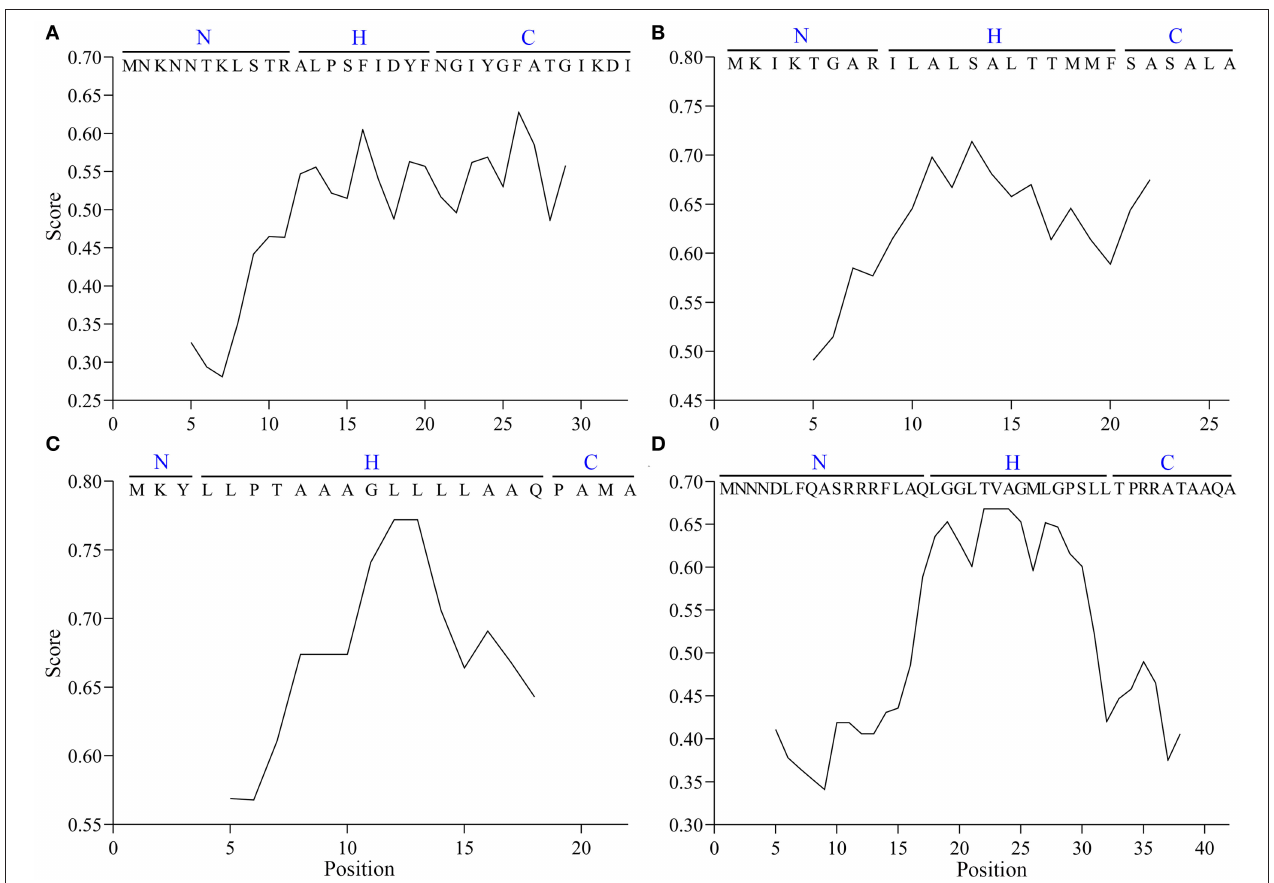
FIGURE 2 | The hydrophobicity scale of SPs of Vip3A (A) , MBP (B) , pelB (C) , and TorA (D) proteins.